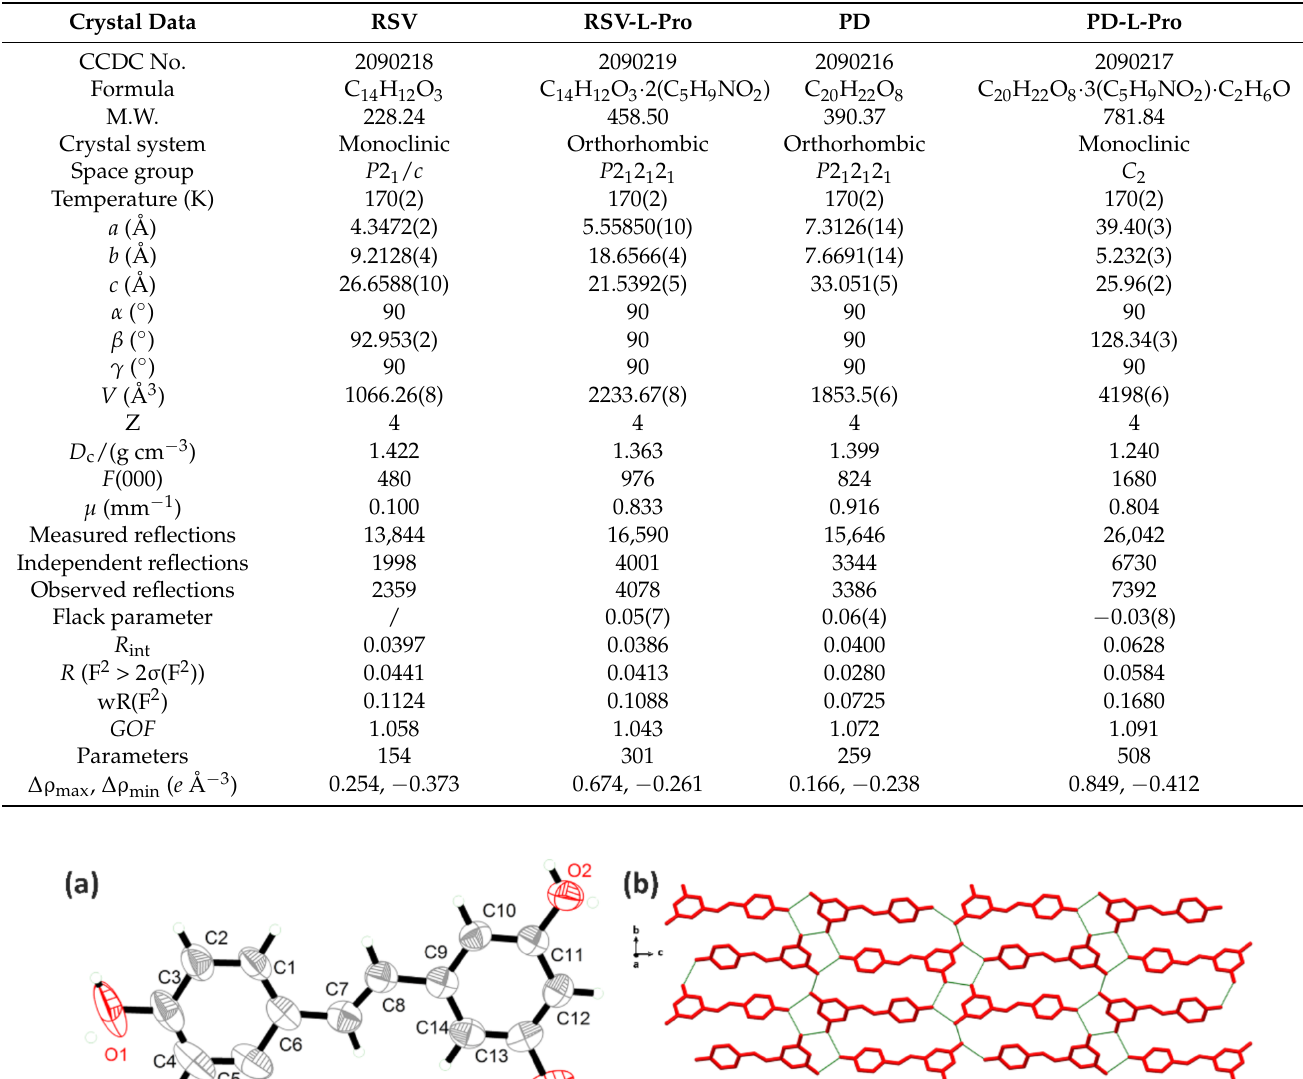
Table 1. Summary of crystallographic data for RSV, PD, RSV-L-Pro, and PD-L-Pro.